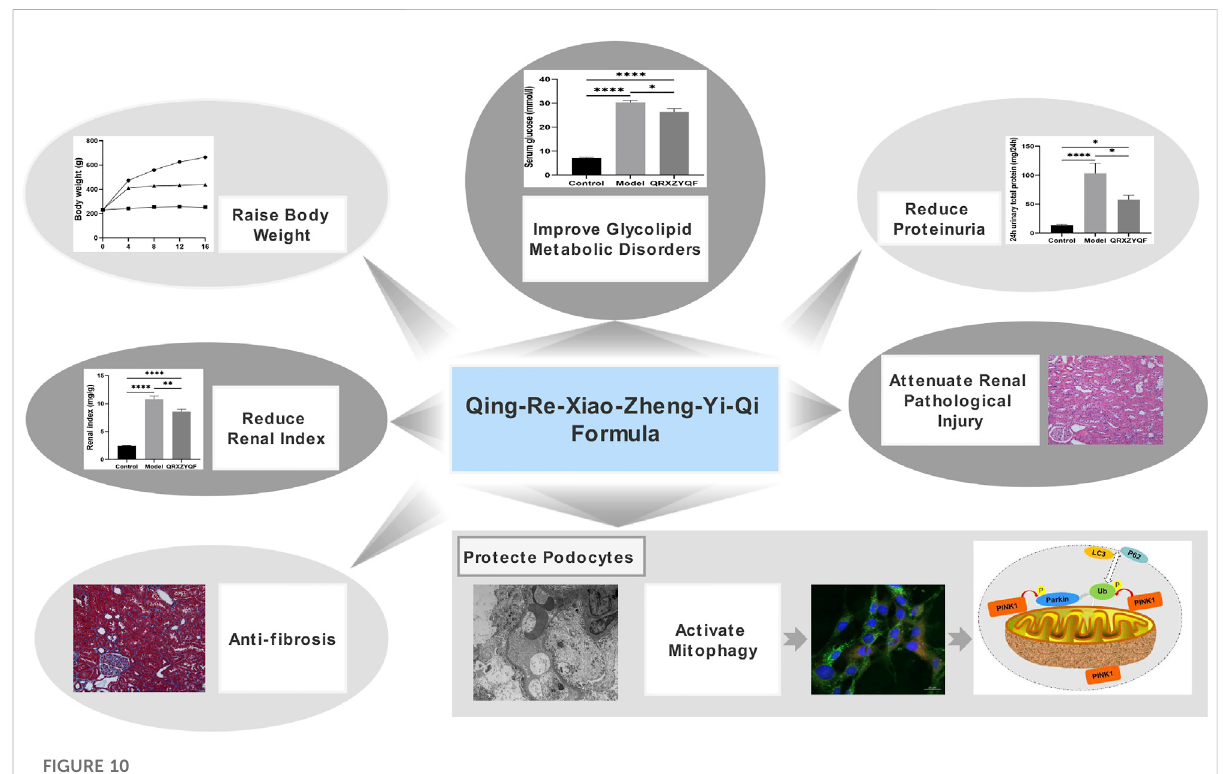
FIGURE 10 Therapeutic effects and underlying mechanisms of